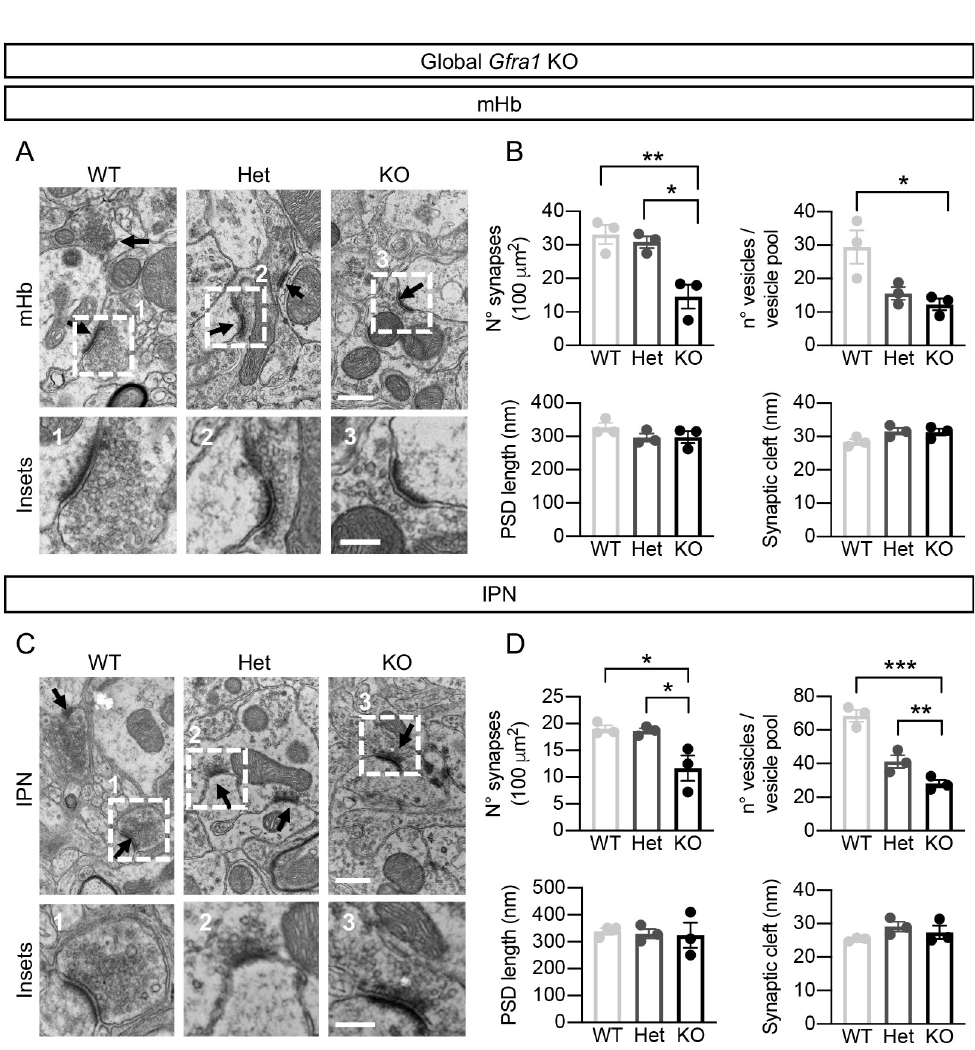
Fig 3. Reduced number of synapses and presynaptic vesicles in mHb and IPN after acute ablation of GFR α 1 in adult mice. (A, C) TEM images showing asymmetric synapses in the mHb (A) and S-synapses in the IPN (C) of WT, Het, and KO mice sacrificed 1 month after tamoxifen treatment. Scale bars, 500 nm and 200 nm (insets). (B, D) Quantification ( ± SEM) of synapse density, synaptic cleft width, number of presynaptic vesicles and PSD length in mHb (B; 50 images per mouse, a total of 240, 207, and 115 synapses analyzed per genotype) and IPN (D; 30–50 images per mouse, 216, 157 and 104 S-synapses analyzed per genotype) of WT, Het, and KO mice. N = 3 mice per group; 1-way ANOVA followed by Tukey post hoc test; � , P < 0.05; �� , P < 0.01; ��� , P < 0.001). The data underlying this figure can be found at https:// figshare.com/projects/Raw_Data_Fernandez-Suarez_et_al_2021/123406. GFR α 1, glial cell–derived neurotrophic factor receptor alpha 1; HET, heterozygous; IPN, interpeduncular nucleus; KO, knockout; mHb, medial habenula; PSD, postsynaptic density; TEM, transmission electron microscopy; WT, wild-type.